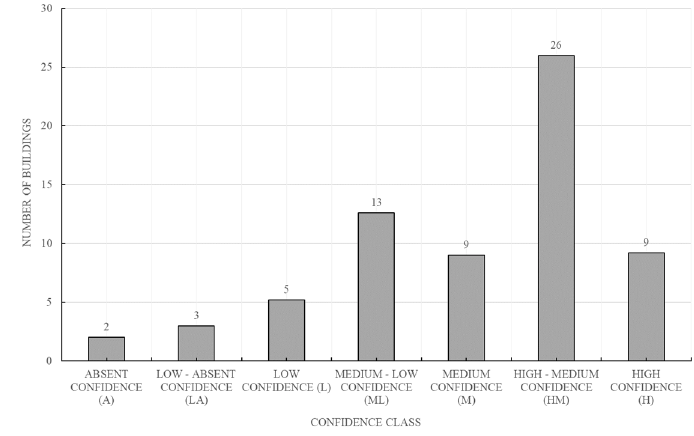
Figure 19. Distribution of the confidence classes in the case study. Table 8. Uncertainty ranges and definition of the confidence classes.